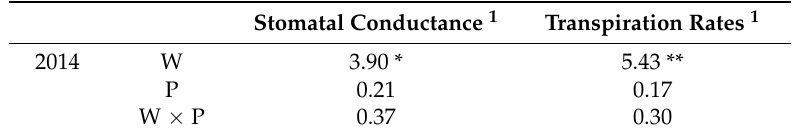
Table A1. F-ratios of two-way ANOVA on the effects of warming (W) and precipitation manipulation (P) on stomatal conductance and transpiration rates of Pinus densiflora seedlings.